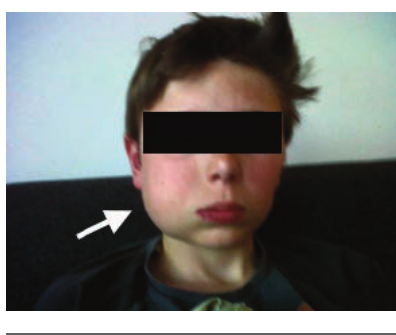
Figure 1. Photograph of the boy at the time of the swelling (white arrow).